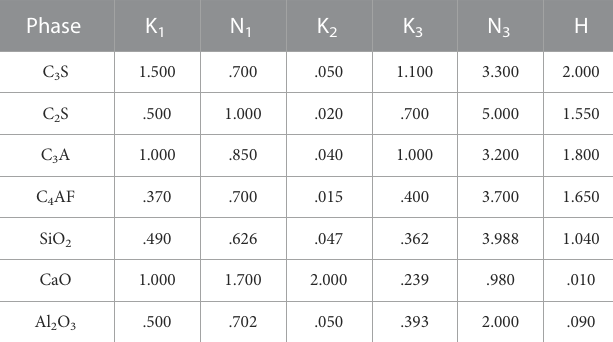
TABLE 3 Empirical reaction rate coef fi cients for the MPK